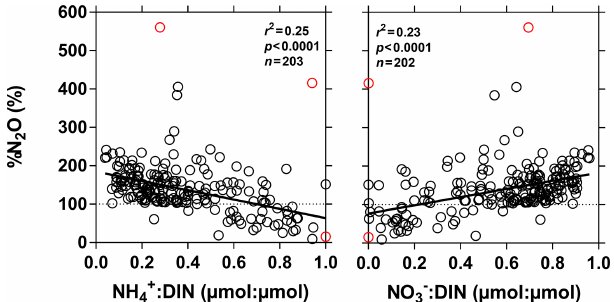
Figure 8. Dissolved N 2 O saturation level (%N 2 O in %), as a function of the ratio of NH + to dissolved inorganic nitrogen 4 + NO − + NO − ) (µmol:µmol) and of the ratio of NO − (DIN = NH + 4 2 3 to DIN (µmol:µmol) in surface waters of the Congo River network. Outliers (red dots) were identified with a Cook’s distance procedure and removed prior to linear regression analysis (solid